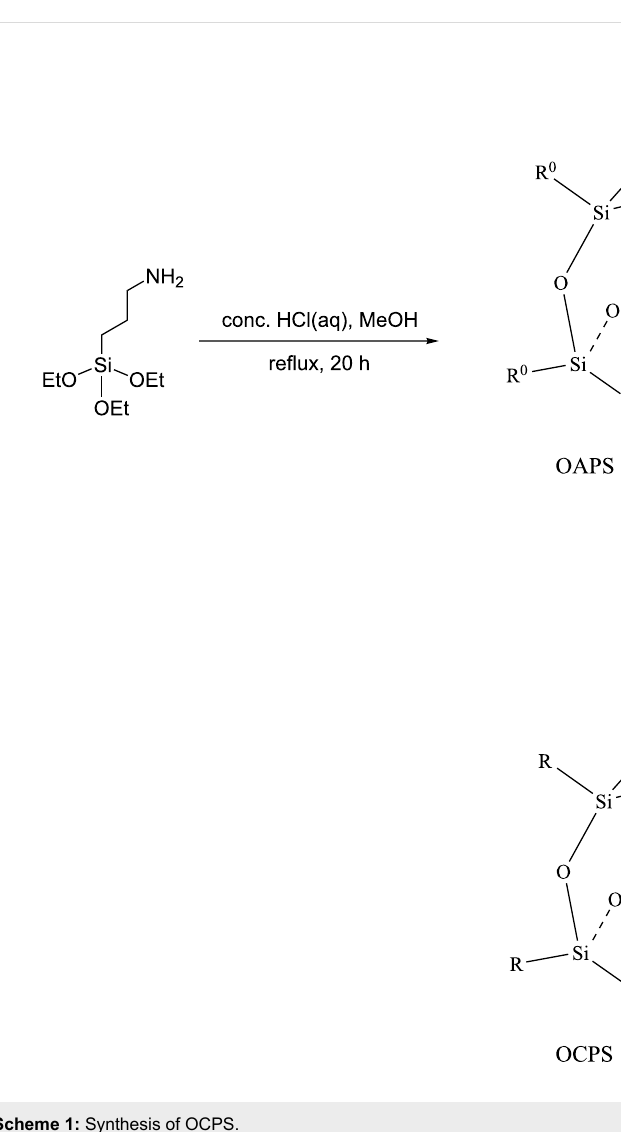
OCPS presented in Figure 2 and the MALDI-TOF-MS spectra, Figure 3a–c reveal the well-defined structures. The SEM images of OCPS in Figure 3d show that OCPS has a microme- ter-sized strip geometry. The details are as follows: (1)